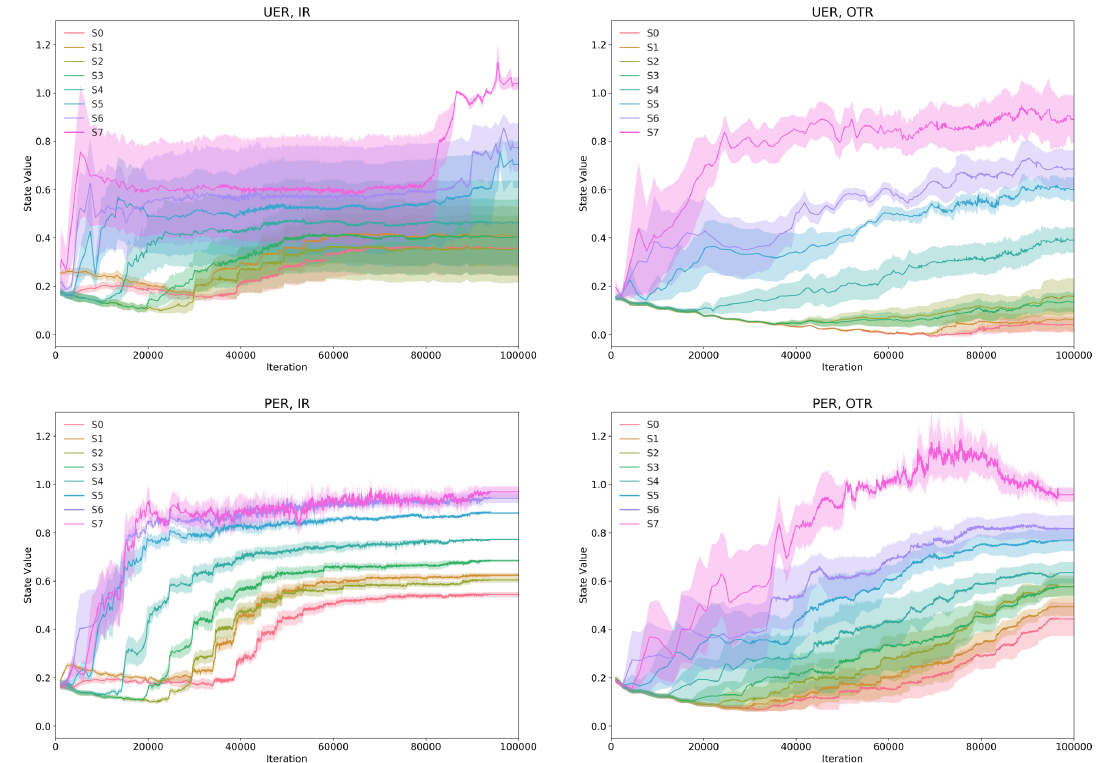
Figure 8: Estimated state values obtained by different methods for sequences of states required for the boiling water task (see Table 1). Each curve is the average of 5 trials. UER= Uniform Experience Replay, PER = Prioritized Experience Replay, IR= Intermediate Reward, OTR= Only-Terminal Reward. The DRL4 was used as the network of the agent and V ( s t +1 ) estimation was global. The confidence interval shows the standard